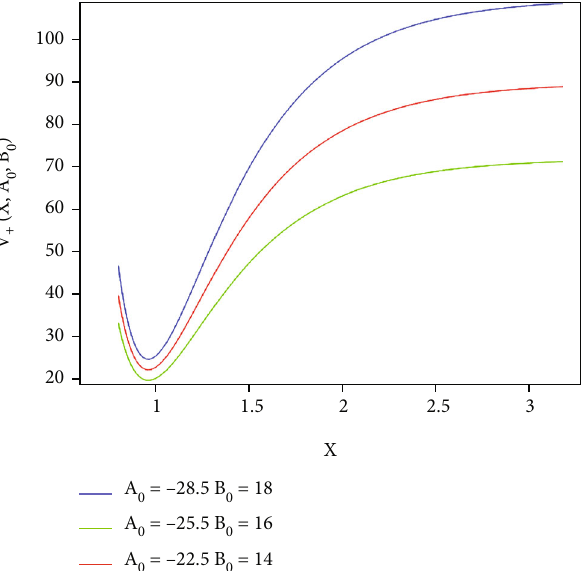
Þ ( m = 2, n = 3, p = 0 : 5 ). = ð x , A , B + 0 0